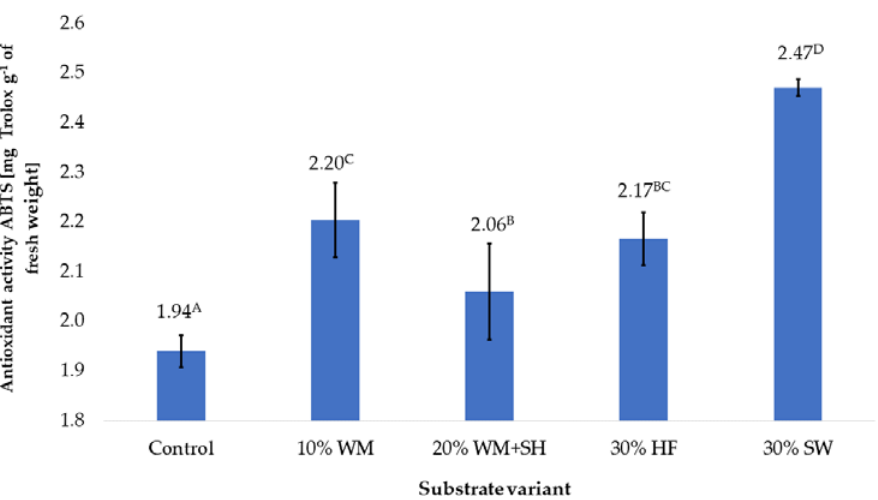
Figure 5. The antioxidant potential of raspberry fruit, depending on the substrate used (n = 36). Note: Significant differences between the results, depending on the substrate variant used, are marked with different letters. Significant level at p < 0.05. Key: Control—100% coconut fibre; 10% WM—90% coconut fibre + 10% fragmented wood material; 20% WM + SH—80% coconut fibre + 10% fragmented wood material + 10% biochar from sunflower husk; 30% HF—70% coconut fibre + 30% hemp fibre; 30% SW—70% coconut fibre + 30% sheep